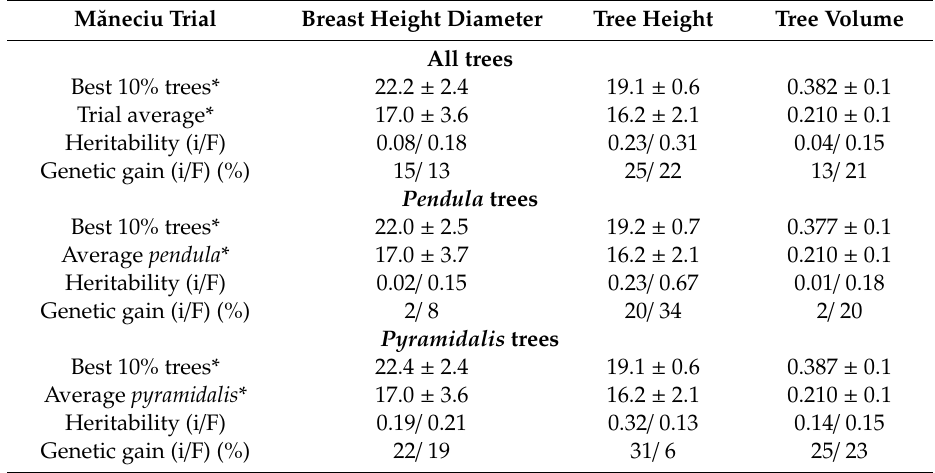
Table 2. Results of growth traits ( ± standard deviation), heritability, and genetic gain in the M ă neciu trial.